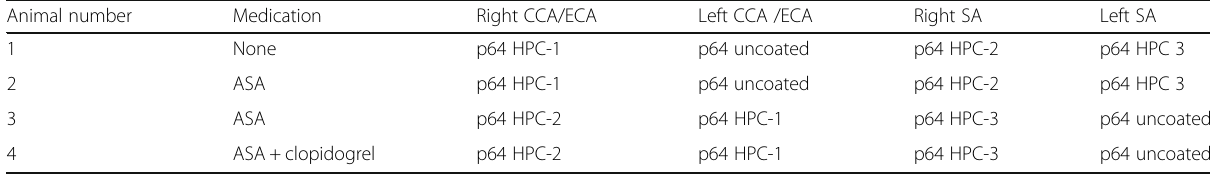
Table 1 Test matrix of the canine models presenting the medication regimens and the locations of each stent Animal number